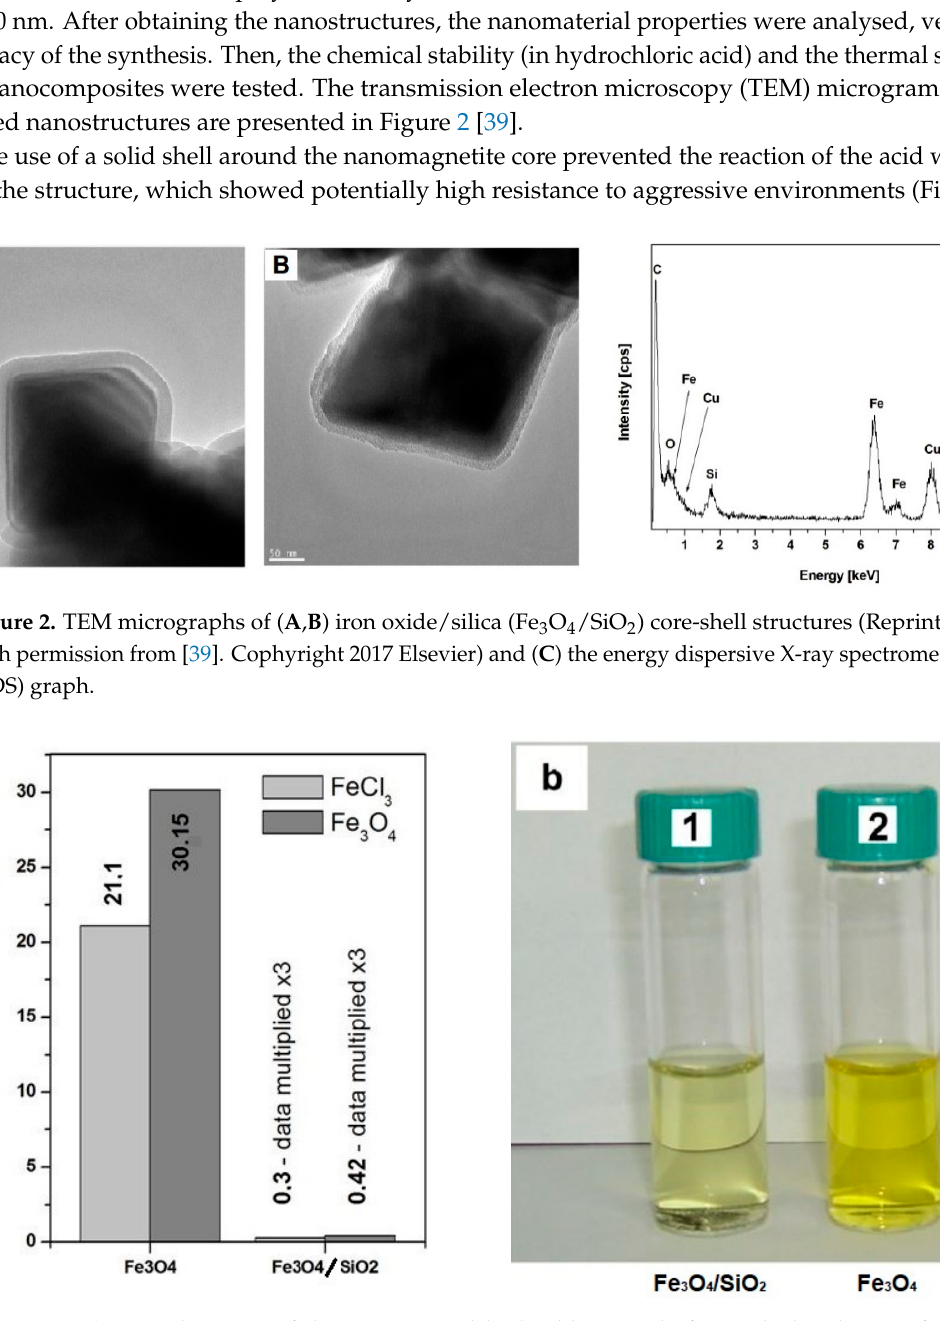
Figure 3. ( a ) Optical images of the concentrated hydrochloric acid after 24 h dissolution of the Fe 3 O 4 /SiO 2 and ( b ) after extraction of undissolved nanomaterials. The samples marked 1 and 2 correspond to the Fe 3 O 4 /SiO 2 and Fe 3 O 4 , respectively. Ultraviolet (UV)-spectroscopy-calculated amounts of the dissolved magnetite and formed iron chloride based on Cendrowski et al. (Reprinted with permission from [39]. Copyright 2017 Elsevier).